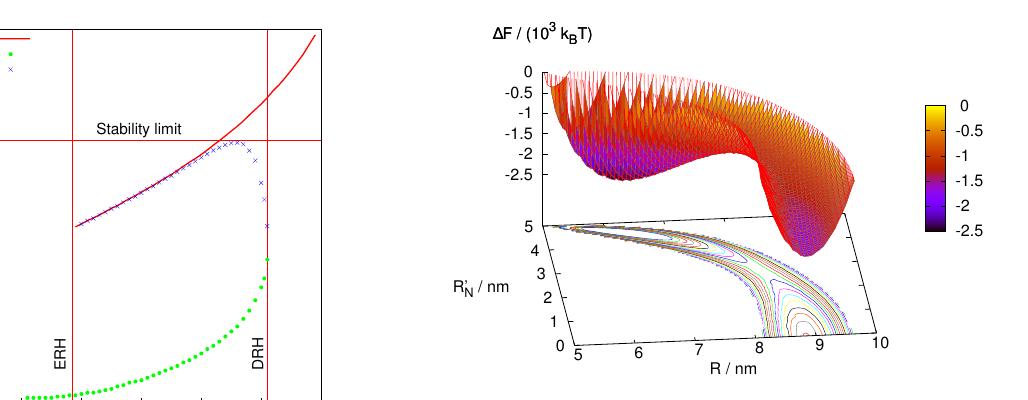
Figure 8. Dimensionless 2-D work of droplet formation, (cid:49)F/(k B T ) , as a function of drop radius R and the residual core radius R (cid:48) according to Eq. (1) for at RH = 78%rh. One can see N Figure 7. Humidity growth factor GF as function of RH accord- two minima in the formation work, which are separated by a sad- ing to Eq. (4) for R N = 5nm. The solid line represents the numer- dle point. These three characteristic points represent the three eq- ical solution of the GKK equation for the homogeneous solution uitable thermodynamic states the aerosol systems can adopt at = 0. The dotted droplet with completely dissolved residual core, R (cid:48) (T, RH ) = ( 298K , 78%rh ) . The first minimum at about (R (cid:48) N curves (symbols “ × ” and “ • ’) represent the two numerical roots of ( 4 . 5nm , 6 . 5nm ) corresponds to the existence of a thermodynami- the combined Ostwald–Freundlich and Gibbs–Kelvin–Köhler equa- cally stable heterogeneous droplet, the second minimum at about tions for the heterogeneous droplet with partially dissolved residual (R (cid:48) ,R) ≈ ( 0nm , 8 . 8nm ) to a thermodynamically stable homoge- N (cid:54)= 0. The graph “het equil 1” corresponds to the thermo- core, R (cid:48) neous solution droplet, and the saddle point at about (R (cid:48) N dynamically stable heterogeneous equilibrium droplet and the graph ( 3nm , 8 . 8nm ) to the existence of conditionally stable heteroge- “het equil 2” to the conditionally stable heterogeneous equilibrium neous droplet. See also Fig. 8.